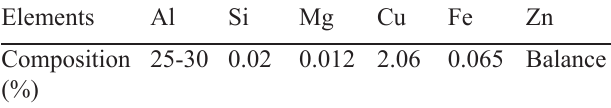
Table 1. Elemental composition of ZA-27